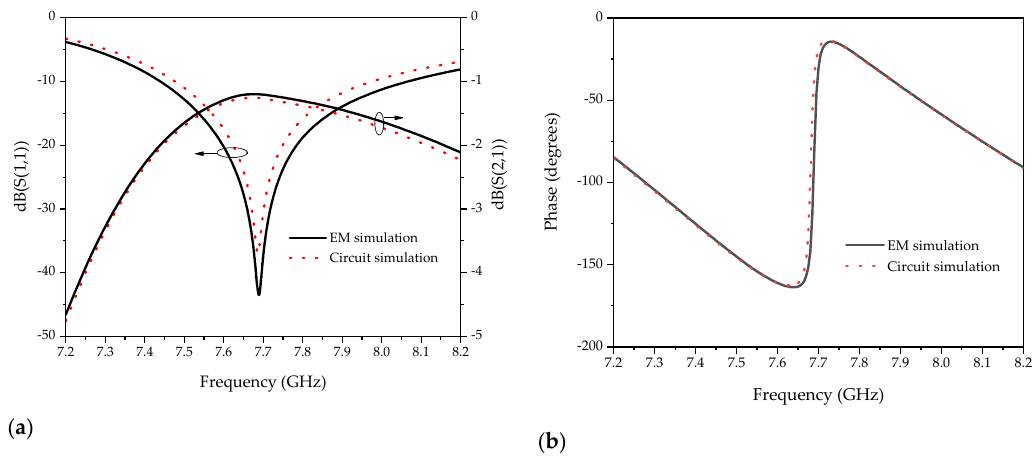
Figure 5. The comparisons of the electromagnetic simulation and the equivalent circuit simulation: ( a ) magnitude response; ( b ) phase response.